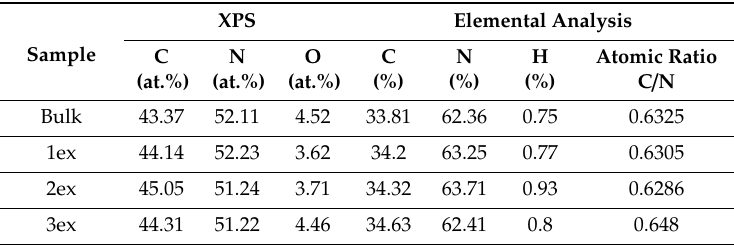
Table 2. Composition determined by XPS and elemental